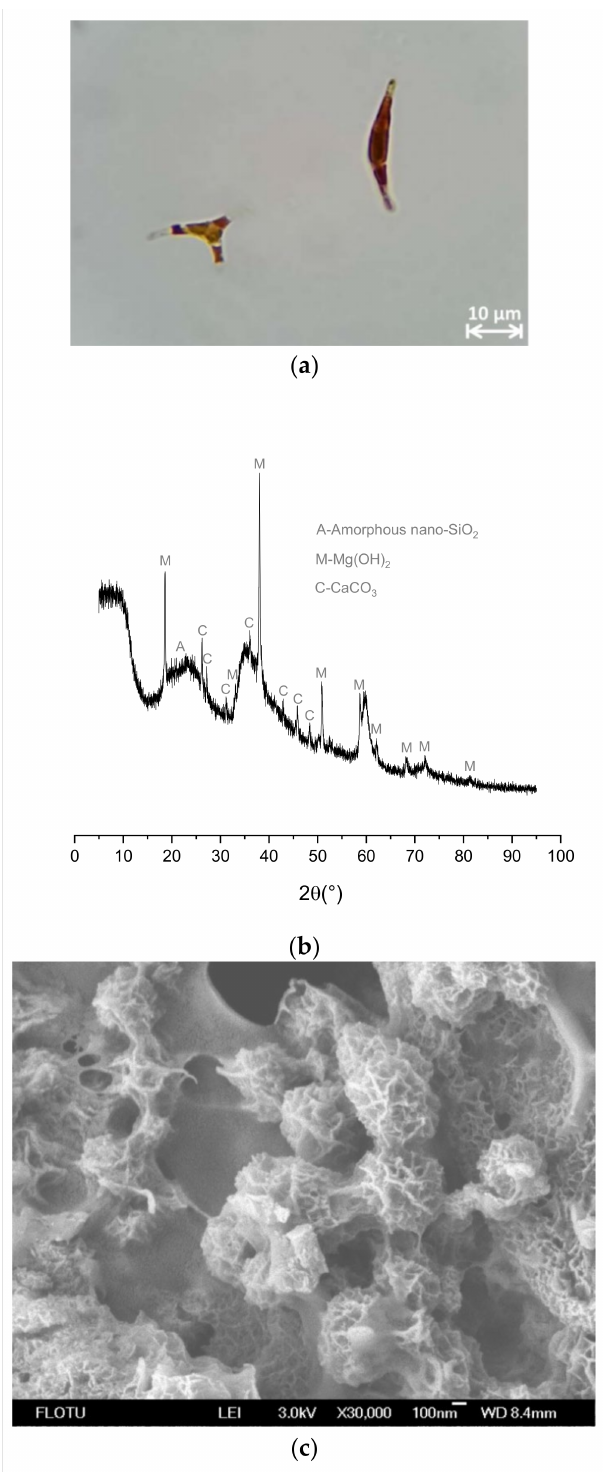
Figure 1. Characterisation of diatoms: ( a ) Observation of raw diatoms (P. tricornutum) under optical microscopy; XRD result ( b ) and SEM image ( c ) of diatom